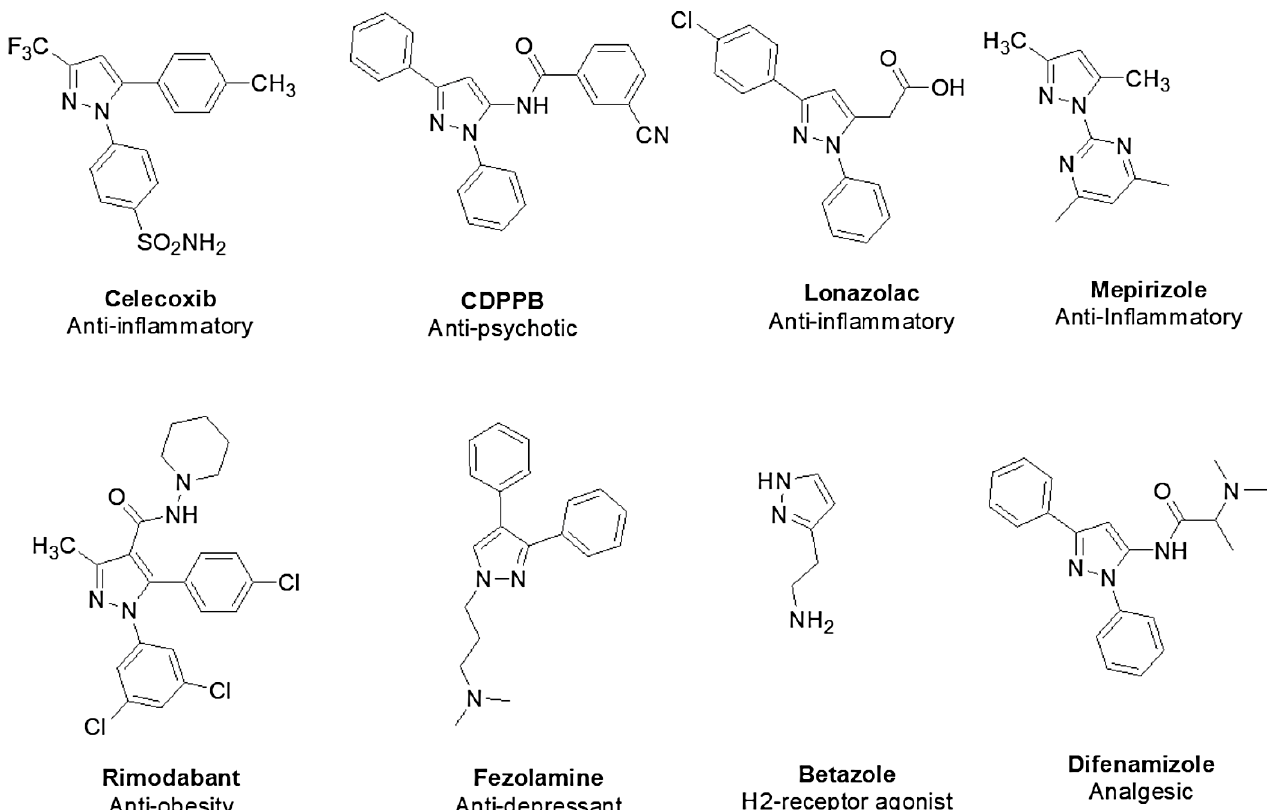
Figure 1. Structure of some of the marketed and well-established therapeutics containing the pyrazole nucleus.